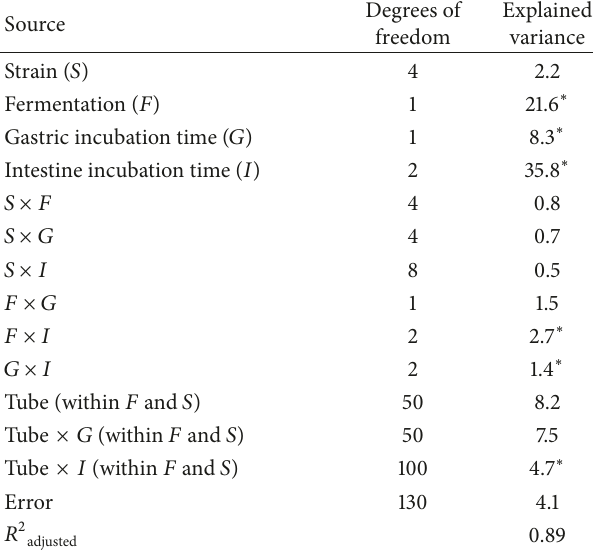
Table 6: ANOVA of E. coli reductions during intestinal fluid treatments in a TFS model †